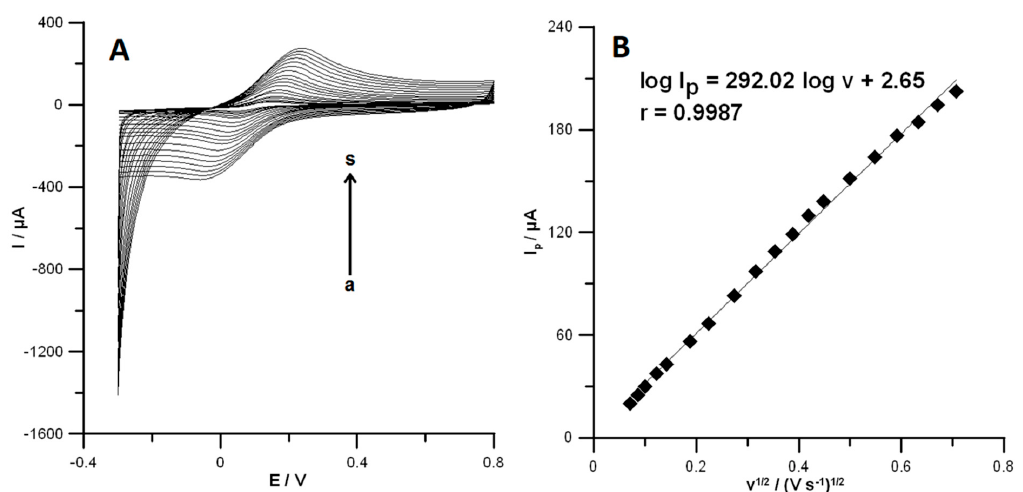
Figure 3. ( A ) Cyclic voltammetric (CV) curves obtained in solution containing 0.1 mol L − 1 KCl and 5.0